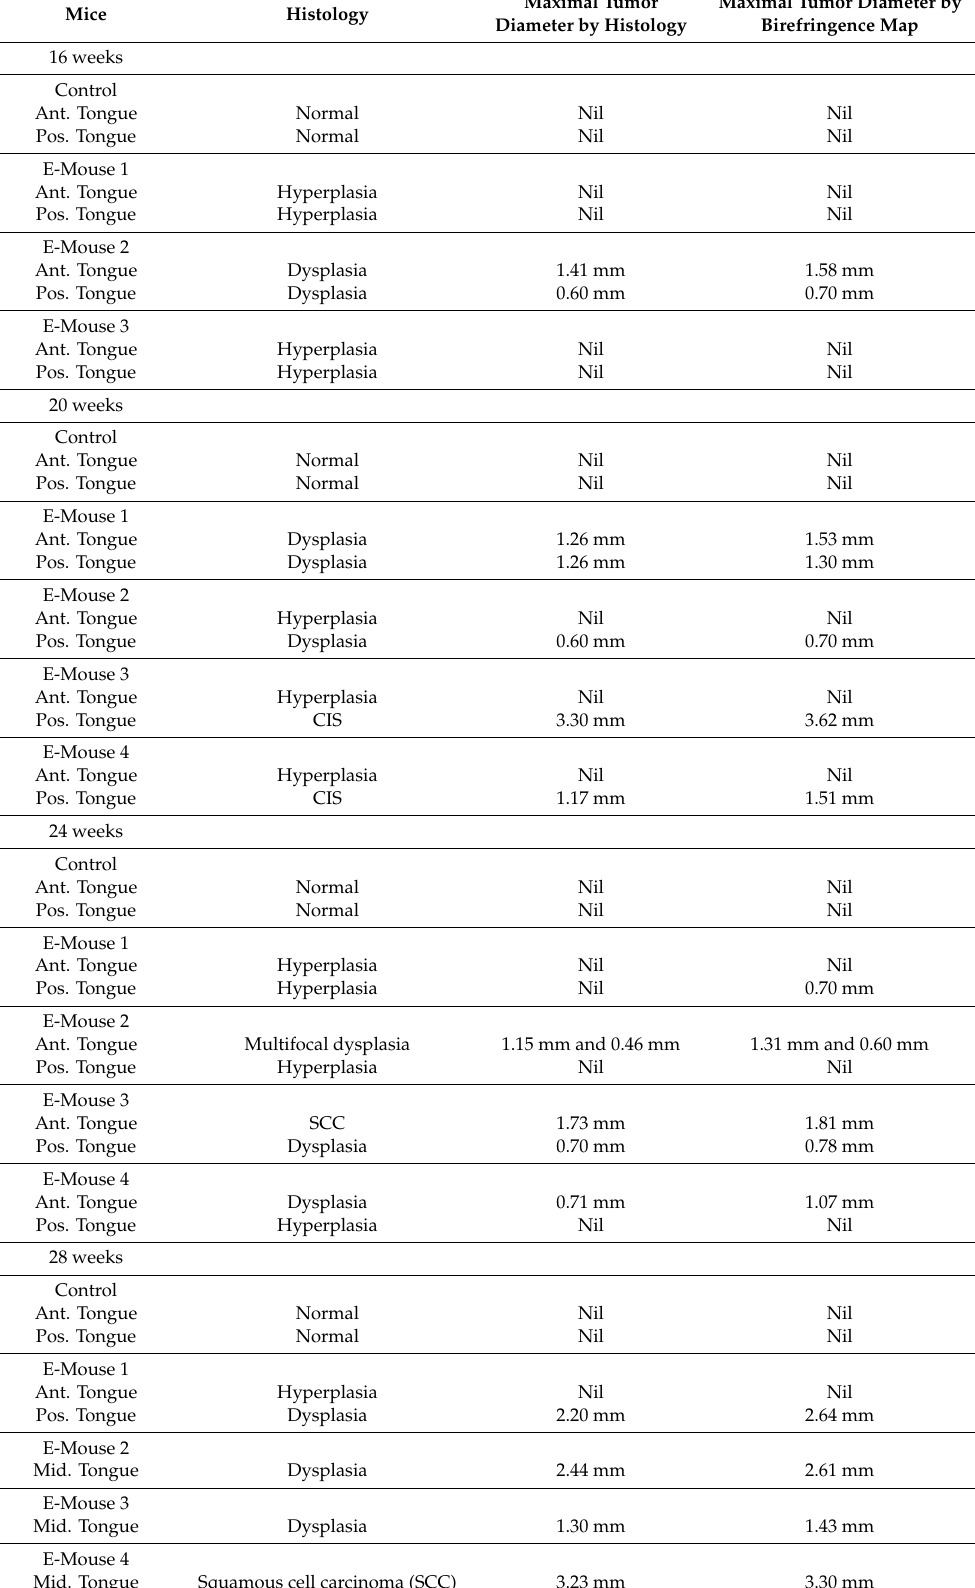
Table 1. Results of histology and en-face birefringence map in all specimens. Mice Histology